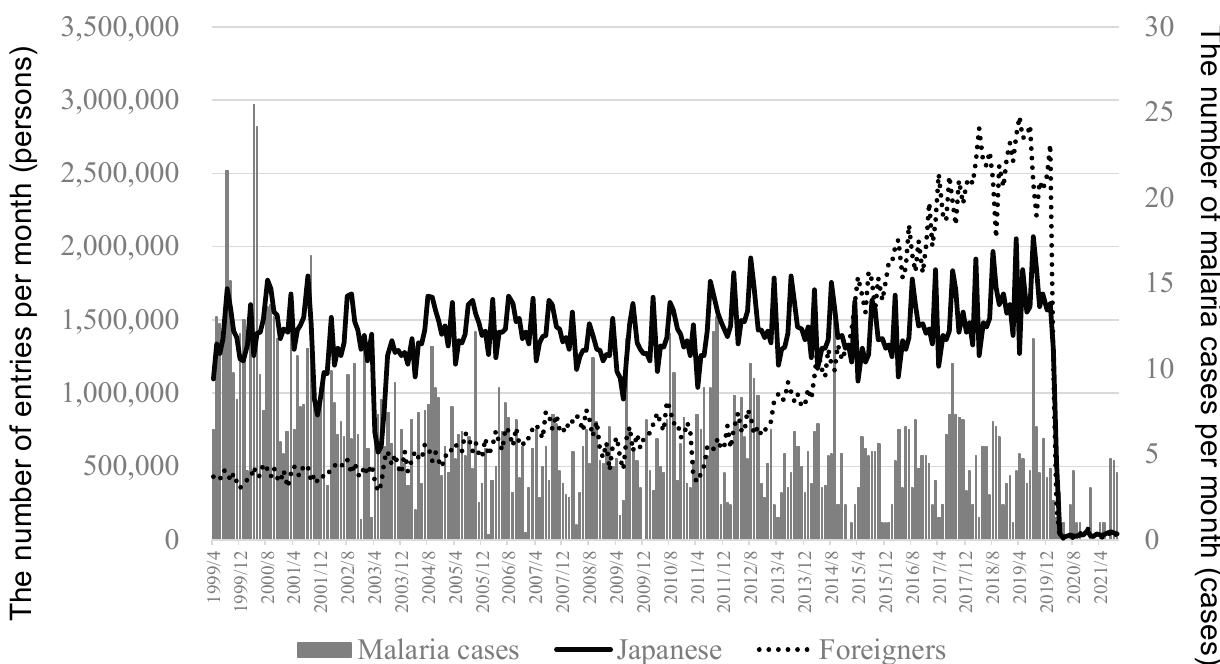
Figure 1. Secular trend in the number of malaria cases and entries for Japanese and foreigners in Japan. The mean value (95% confidence intervals) in the number of entries per month was 1.32 (1.31–1.33) million persons for Japanese between April 1999 and September 2021, and the respective value was 0.97 (0.95–0.98) million persons for foreigners. The bend point for the number of entries for foreigners was on 24 October 2012. Table 1. Risk ratio (RR) of malaria case numbers per 100,000 persons increment of entries for Japanese and foreigners per day.